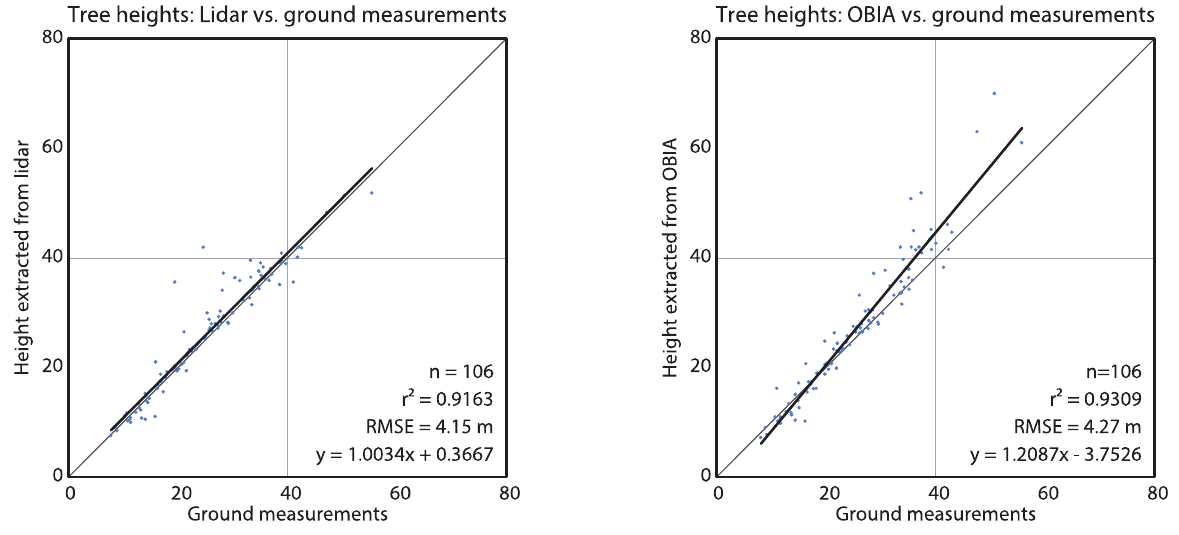
Figure 7. Ground reference data vs . the lidar-derived ( A ) and OBIA-derived ( B ) tree